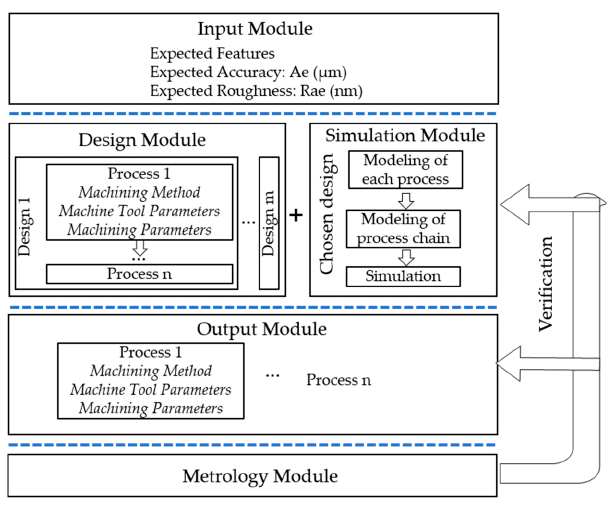
Figure 1. Framework of a machining process chain system.